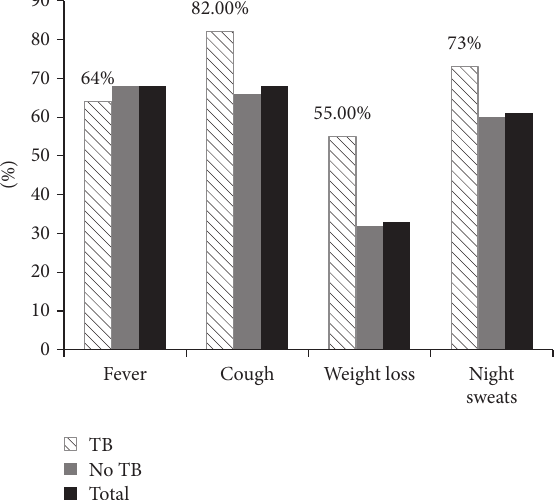
Figure 1: TB symptom distribution of the study participants in Gondar, North West Ethiopia,